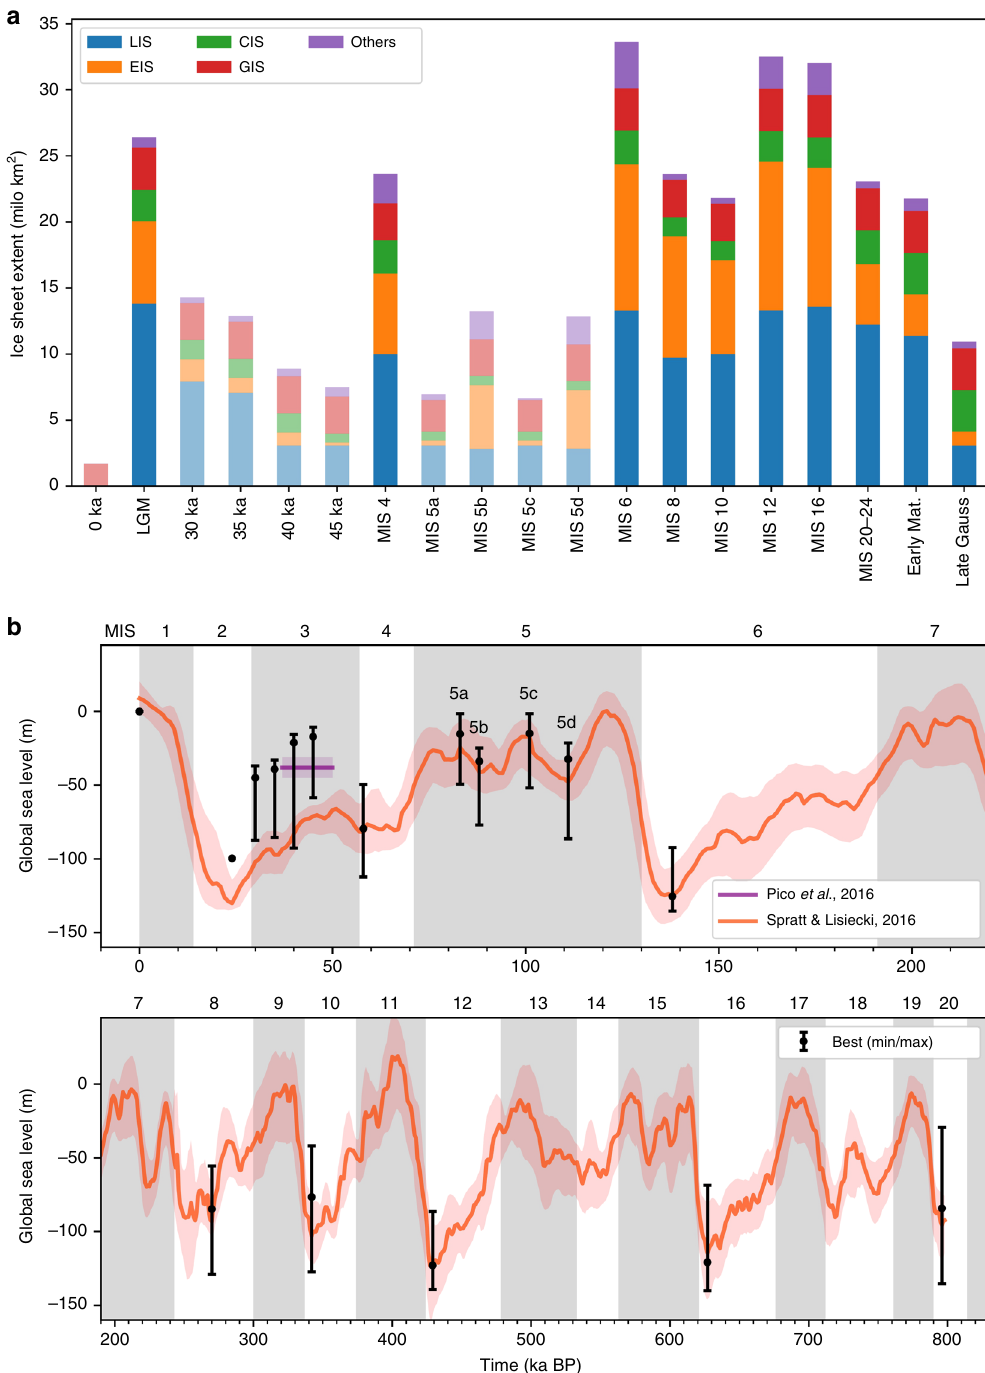
Fig. 2 Extent and cumulative ice volume of NH ice sheets. a shows bar chart of ice-sheet extent at 18 time-slices through the Quaternary relative to present-day extent (0 ka), with each bar composed of individual ice-sheet extents. Bars with low-saturation colours are the comparatively warm intervals of MIS 3 and 5 and the present day, whereas high-saturation bars show the maximum ice-sheet extent during full-glacial periods. b shows the sea-level equivalent represented by the cumulative volume of the reconstructed NH ice sheets in this study (black bars), superimposed on previously published estimates of global sea level for the last 0.8 Ma. Black circles show the sea-level equivalent represented by our best-estimate reconstructions. Because our cumulative ice volumes assume that the NH ice sheets reached their maximum extent at the same time, our sea-level-equivalent estimates for the full- glacial periods of MIS 2, 4, 6, 8, 10, 12, 16 and 20 – 24 are plotted at the coldest point (lowest global sea level) within each of these time-slices. For the comparatively warm periods of MIS 5a and 5c, for which we attempted to capture the peak warmth, our sea-level estimates are plotted at the warmest point (highest global sea level) within these